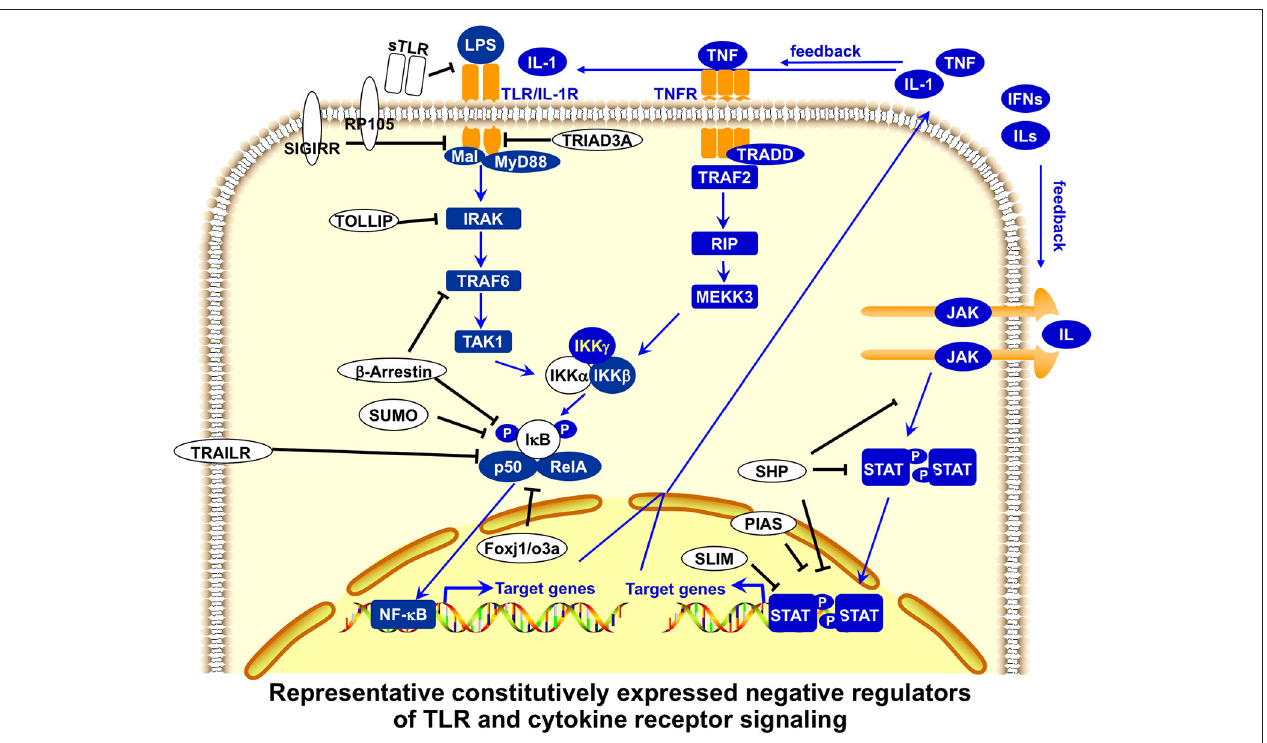
FIGURE 3 | Representative, constitutively expressed negative regulators of TLR and cytokine receptor signaling in APCs. Toll-like receptor (TLR) signaling is regulated by constitutively expressed negative regulators at multiple points. Soluble forms of Toll-like receptors (sTLR) inhibit the binding of membrane-bound TLR to microbial ligands. Membrane-bound SIGIRR (single immunoglobulin interleukin-1-related receptor) binds to TLR4 and IRAK (interleukin-1 receptor-associated kinase), and terminates the downstream TLR signaling pathways, whereas TRAIL-R (tumor-necrosis factor-related apoptosis-inducing ligand receptor) suppresses nuclear factor- κ B (NF- κ B) activation, perhaps by stabilizing I κ B (inhibitor of NF- κ B) and protecting it from degradation. Intracellular TRIAD3A ubiquitinates certain TLRs for degradation. TOLLIP (Toll-interacting protein) suppresses IRAK function by inhibiting TLR signaling. NOD2 might inhibit TLR2 signaling by suppressing NF- κ B activity. SUMO sumoylates and stabilizes the inhibitor of NF- κ B. Transcription factors Foxj1 and Foxoa3 activate expression of the inhibitor of NF- κ B. Cytokine receptor signaling is also regulated by constitutively expressed negative regulators at multiple points. SHP proteins dephosphorylate activated JAKs or receptors. PIAS proteins block the binding of STATs and SUMOylate STATs to inhibit their transcriptional activation, whereas STAT-interacting LIM protein (SLIM) ubiquitinates STAT1 and STAT4 for degradation. Many of these negative regulators also play important roles in regulating T-cell activation and function